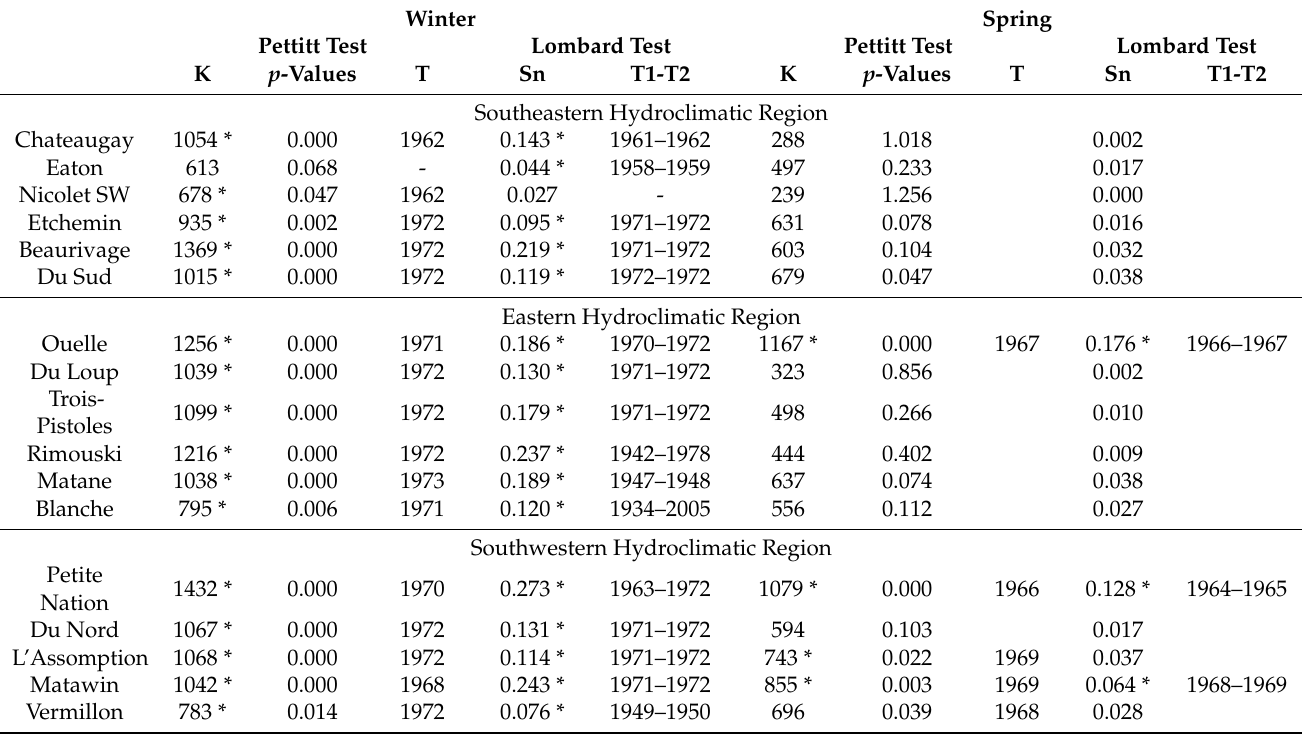
Table 5. Pettitt and Lombard test results applied to maximum daily flow series in winter and spring from 1930–2019.